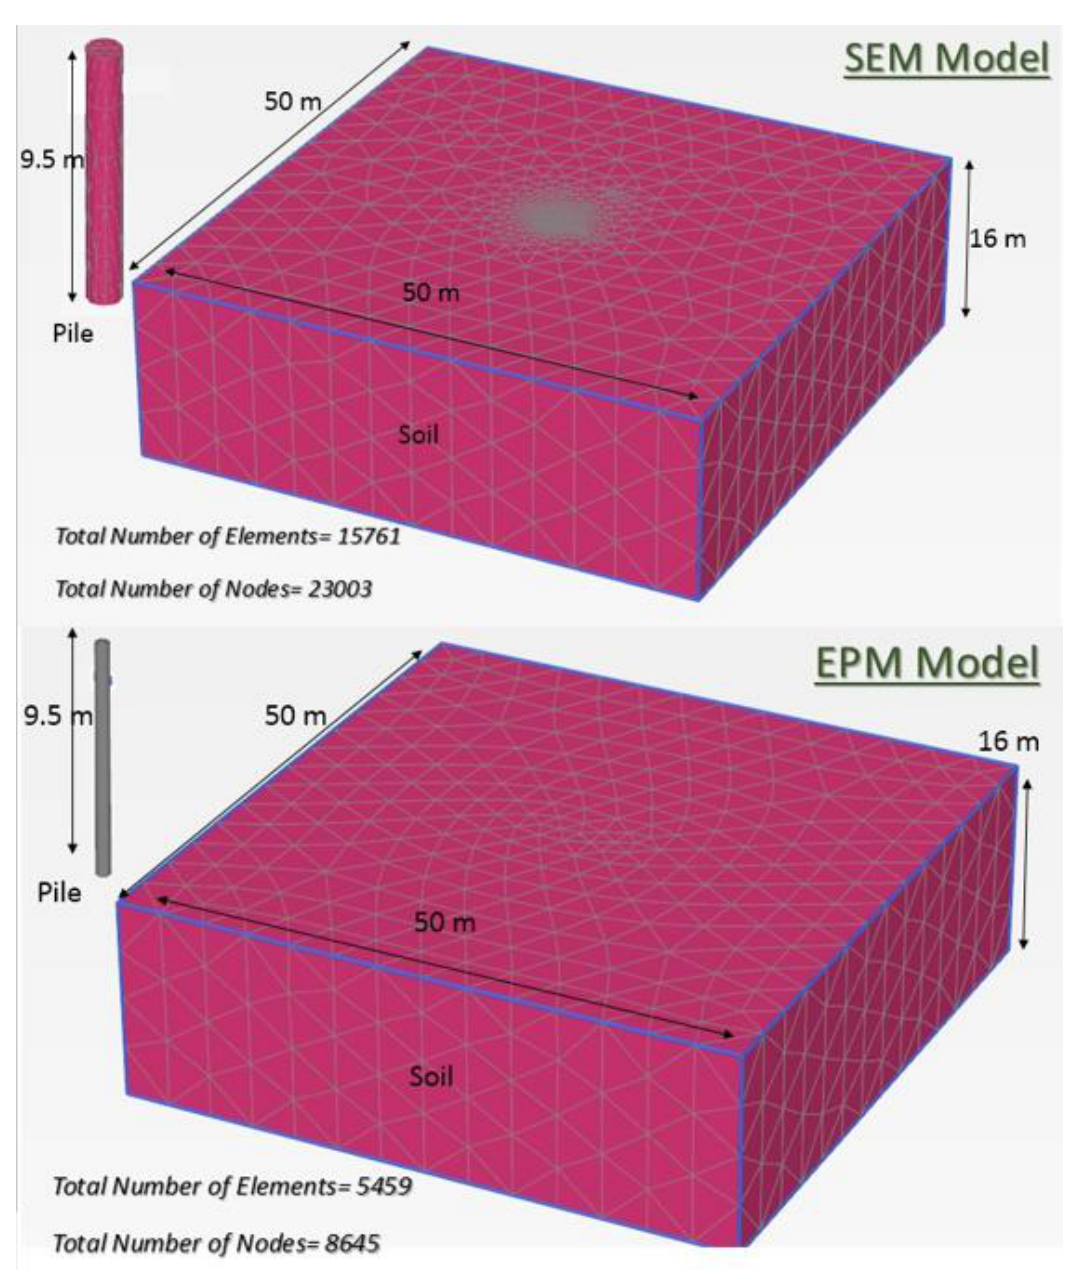
Fig. 12. Model properties for SEM and EPM